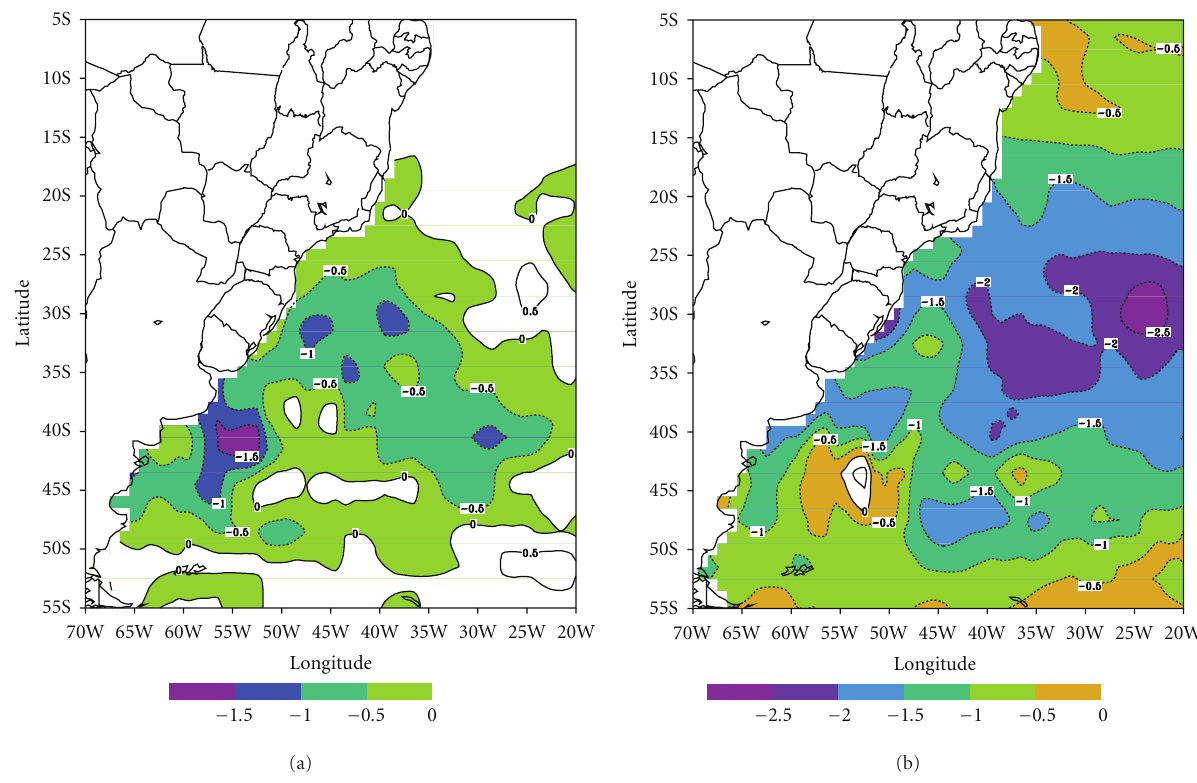
Figure 7: SST anomaly from NOAA-OI for June 1985 (a) and 2000 (b) relative to the mean from 1982 to 2008.